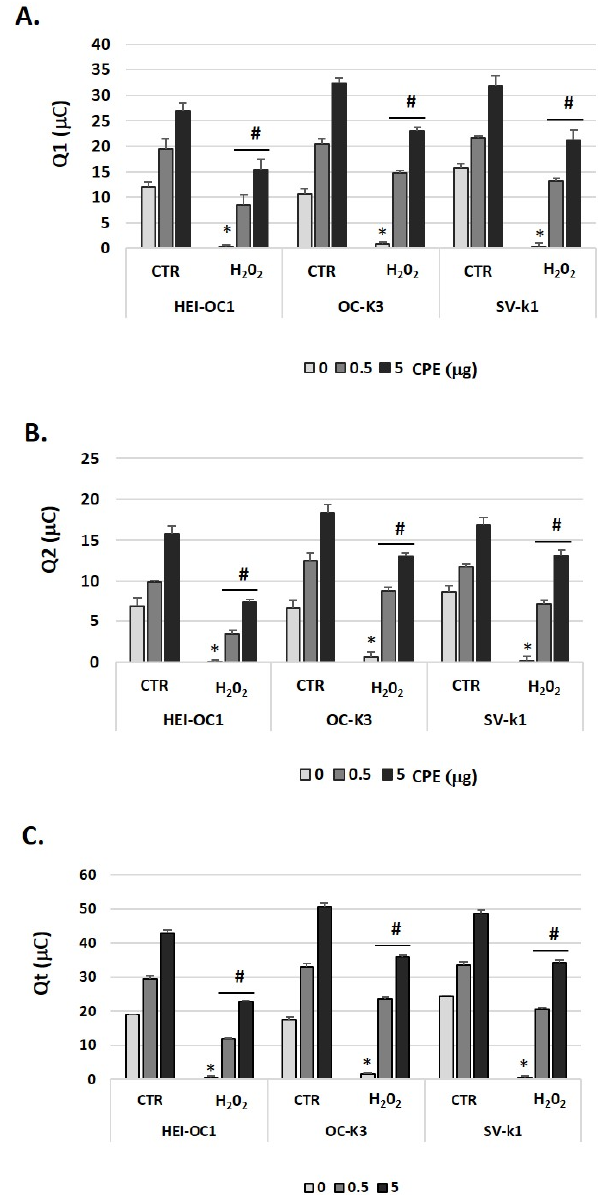
Figure 7. Cocoa treatment modulated total antioxidant response in senescence auditory cells. ( A ) Q1 (fast antioxidants), ( B ) Q2 (slow antioxidants), and ( C ) Qt (total antioxidant response: Q1 + Q2) ( µ C) were measured by e-BQC lab system in cell supernatants of HEI-OC1, OC-k3, and SV-k1 cells post-treatments. Experimental groups: CTR group (0, 0.5 and 5 µ g/mL of CPE for 20 h) and H 2 O 2 group (induced cellular senescence with 100 µ M for 1 h in all groups: 0, 0.5 and 5 µ g/mL of CPE for 20 h). The values represent the mean ± SD of micro-Coulomb ( µ C) in triplicate. * p < 0.05 vs. CTR group; # p < 0.05 vs. H 2 O 2 group ( n = 4).